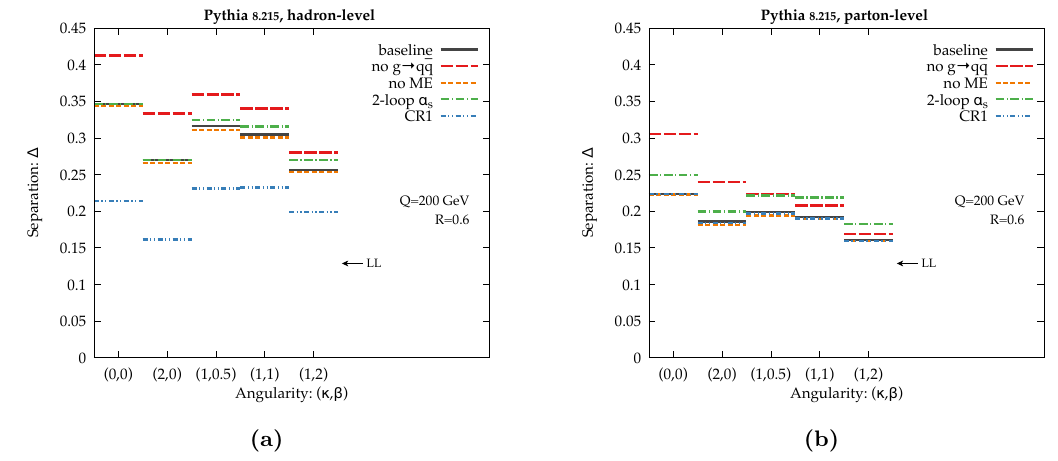
Figure 9. Settings variations for Pythia 8.215 . Shown are (a) hadron-level and (b) parton-level results for the classi(cid:12)er separation (cid:1) derived from the (cid:12)ve benchmark angularities. though, so the true impact of these corrections might be larger than the relatively small e(cid:11)ect seen for this